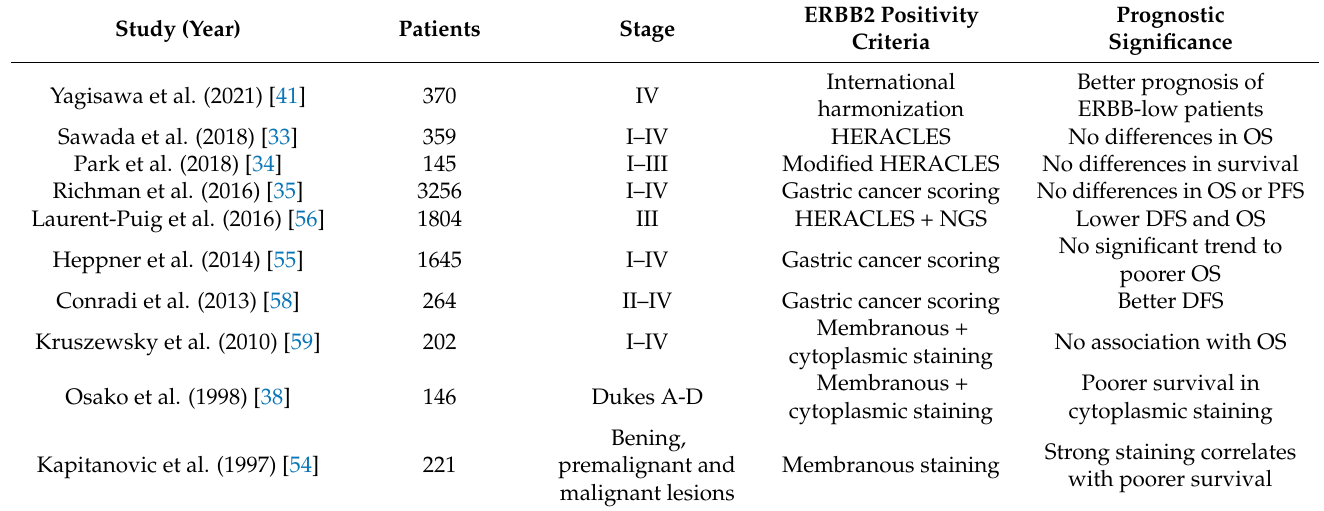
Table 1. Main studies on the prognostic significance of ERBB2